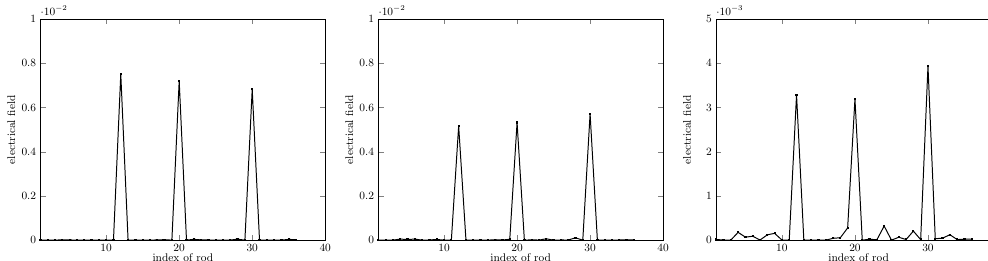
Figure 5. Retrieval for 1, 2, and 3 missing rods, left to right, and sketches of the micro-structure. MSM, multiple scattering expansion.